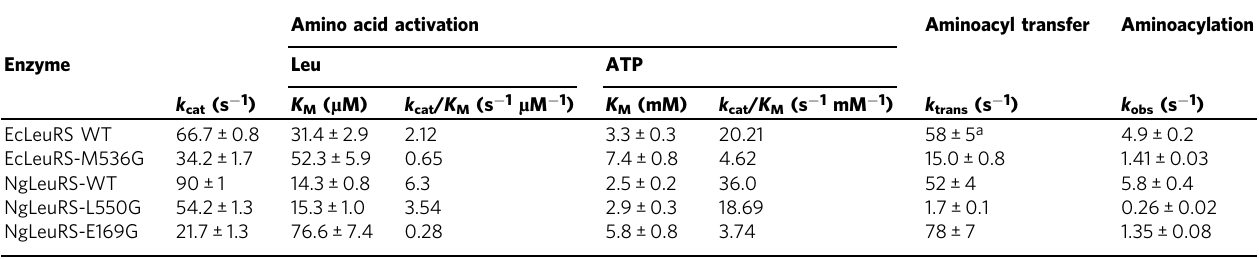
Table 1 Kinetic parameters for wild type and mutant LeuRSs from N. gonorrhoeae and E. coli